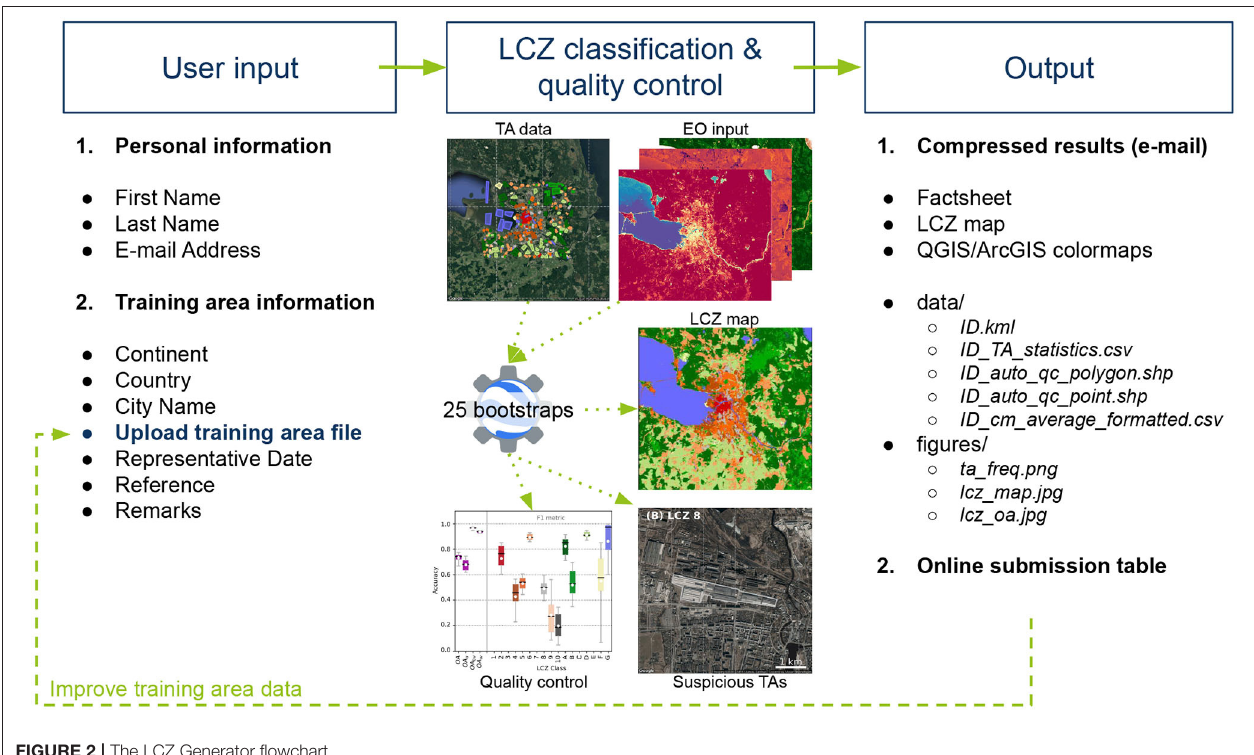
FIGURE 2 | The LCZ Generator flowchart.